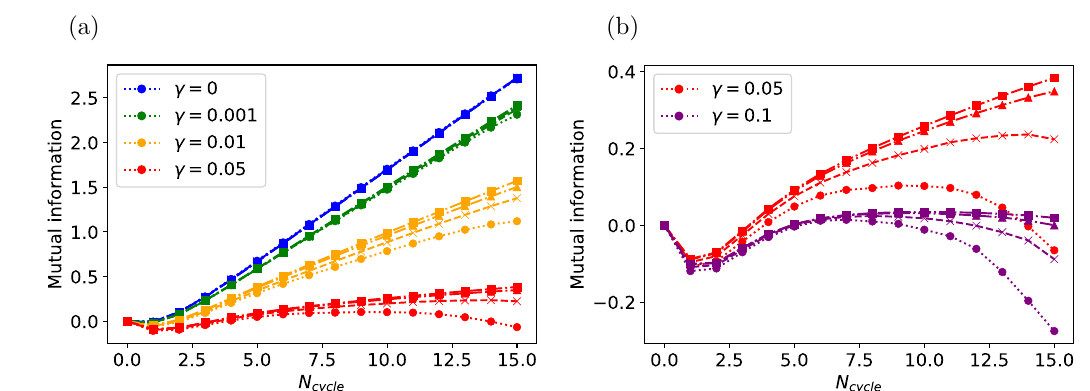
Figure 7: (a) Growth of half-system mutual information I ([ 0, L / 2 ] , [ L / 2, L ]) for | T / L | = 0.05, T / L = 0.05, with different dissipations, and system sizes 0 1 L = { 100,200,500,800 } (circle, cross, triangle, square). (b) Same plot for differ- ent values of γ